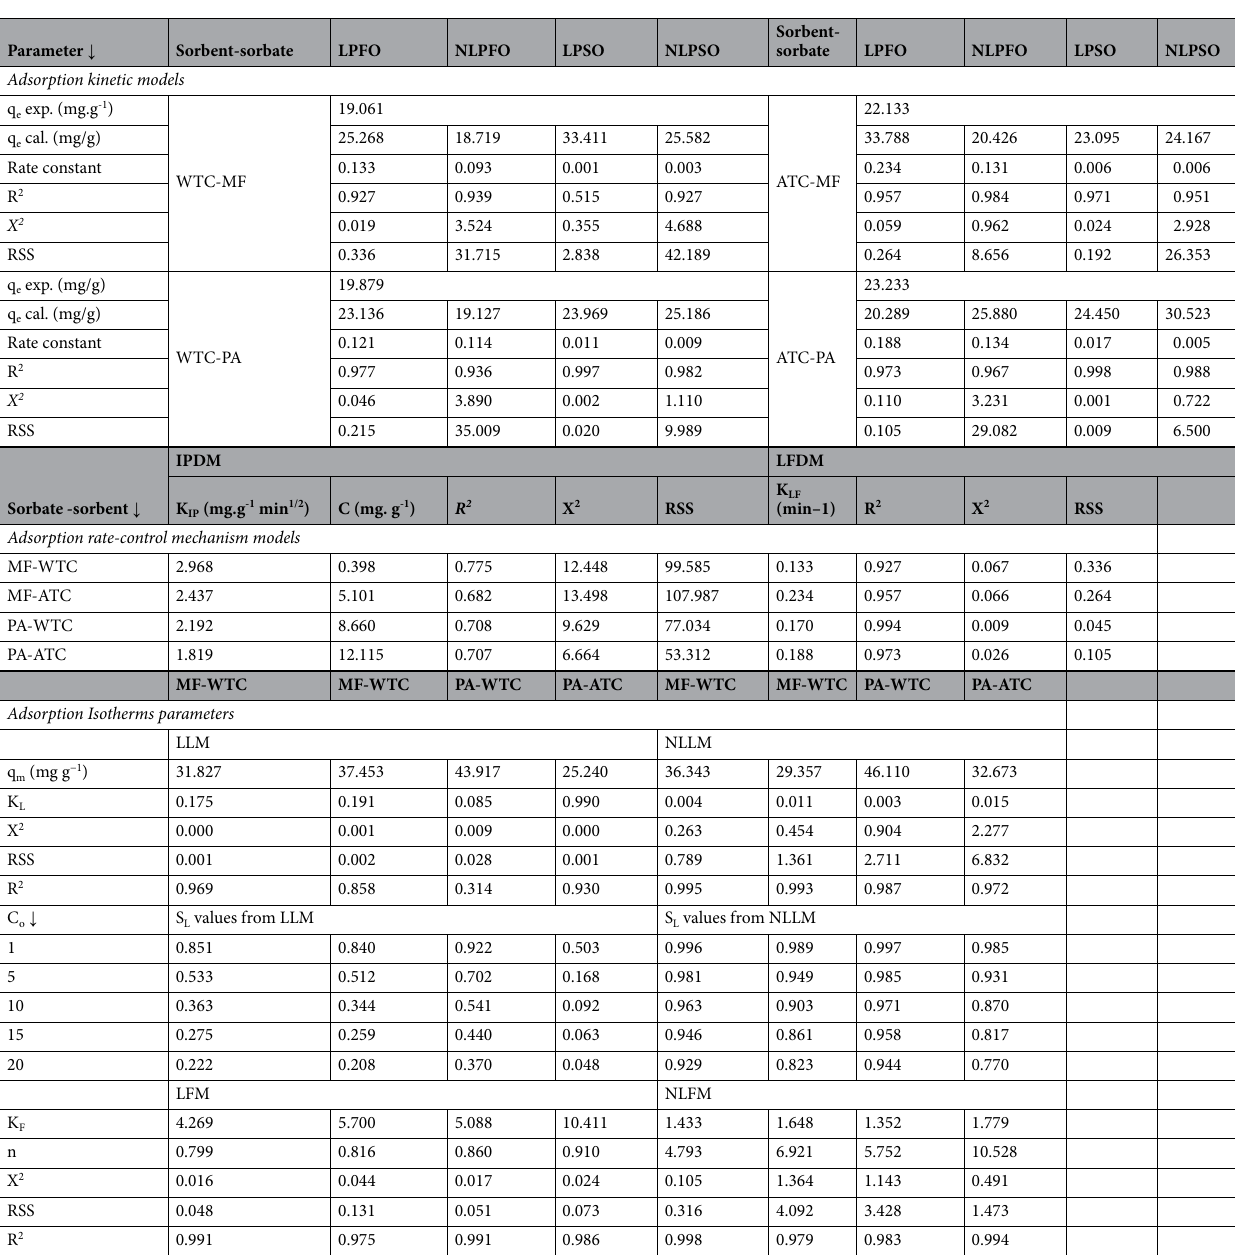
Table 1. The kinetics and isotherms parameters for the adsorption of MF and PA on WTC and